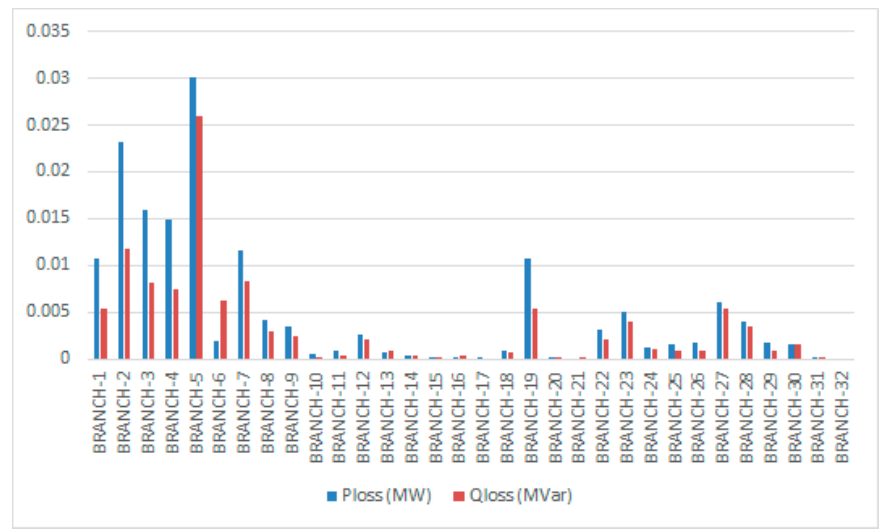
Figure 4. Base case power losses of the IEEE 33-bus radial distribution system with no DG.